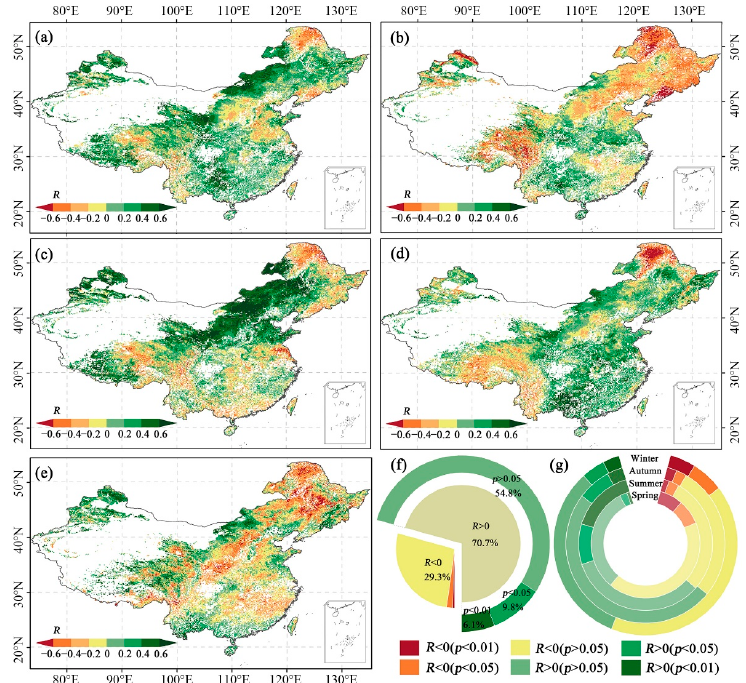
Figure 5. Spatial distribution of the correlation coefficients ( R ) between gross primary productivity (GPP) and standardized precipitation evapotranspiration index (SPEI) across China, under ( a ) annual and seasonal temporal scales including ( b ) spring, ( c ) summer, ( d ) autumn, and ( e ) winter from 2001 to 2020, and ( f ) annual and ( g ) seasonal frequency distribution of correlation coefficients ( R ) between GPP and SPEI.